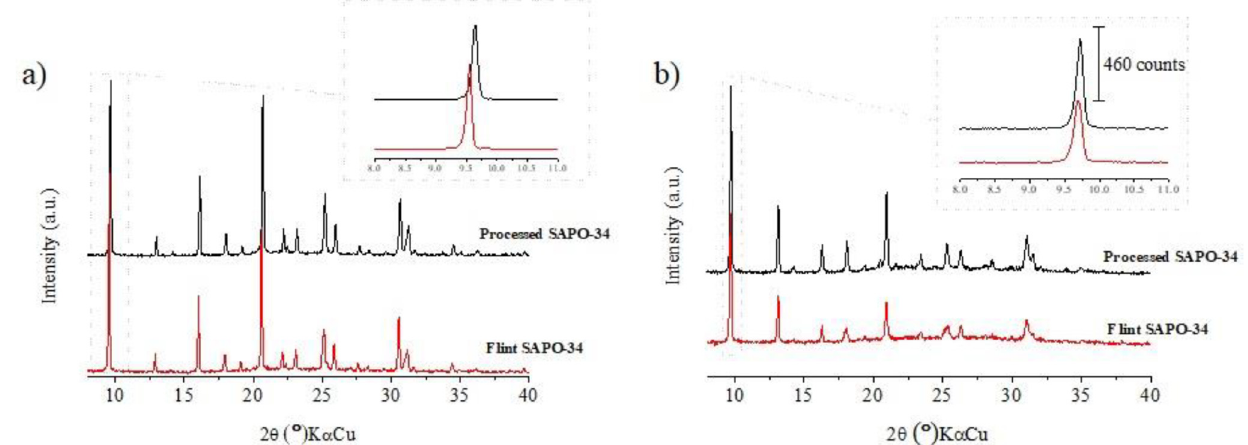
Figure 7. ( a ) Comparison of the products synthesized: XRD processed SAPO-34 (non-calcined) and flint SAPO-34 (non-calcined); ( b ) XRD processed SAPO-34 (calcined) and flint SAPO-34 (calcined).